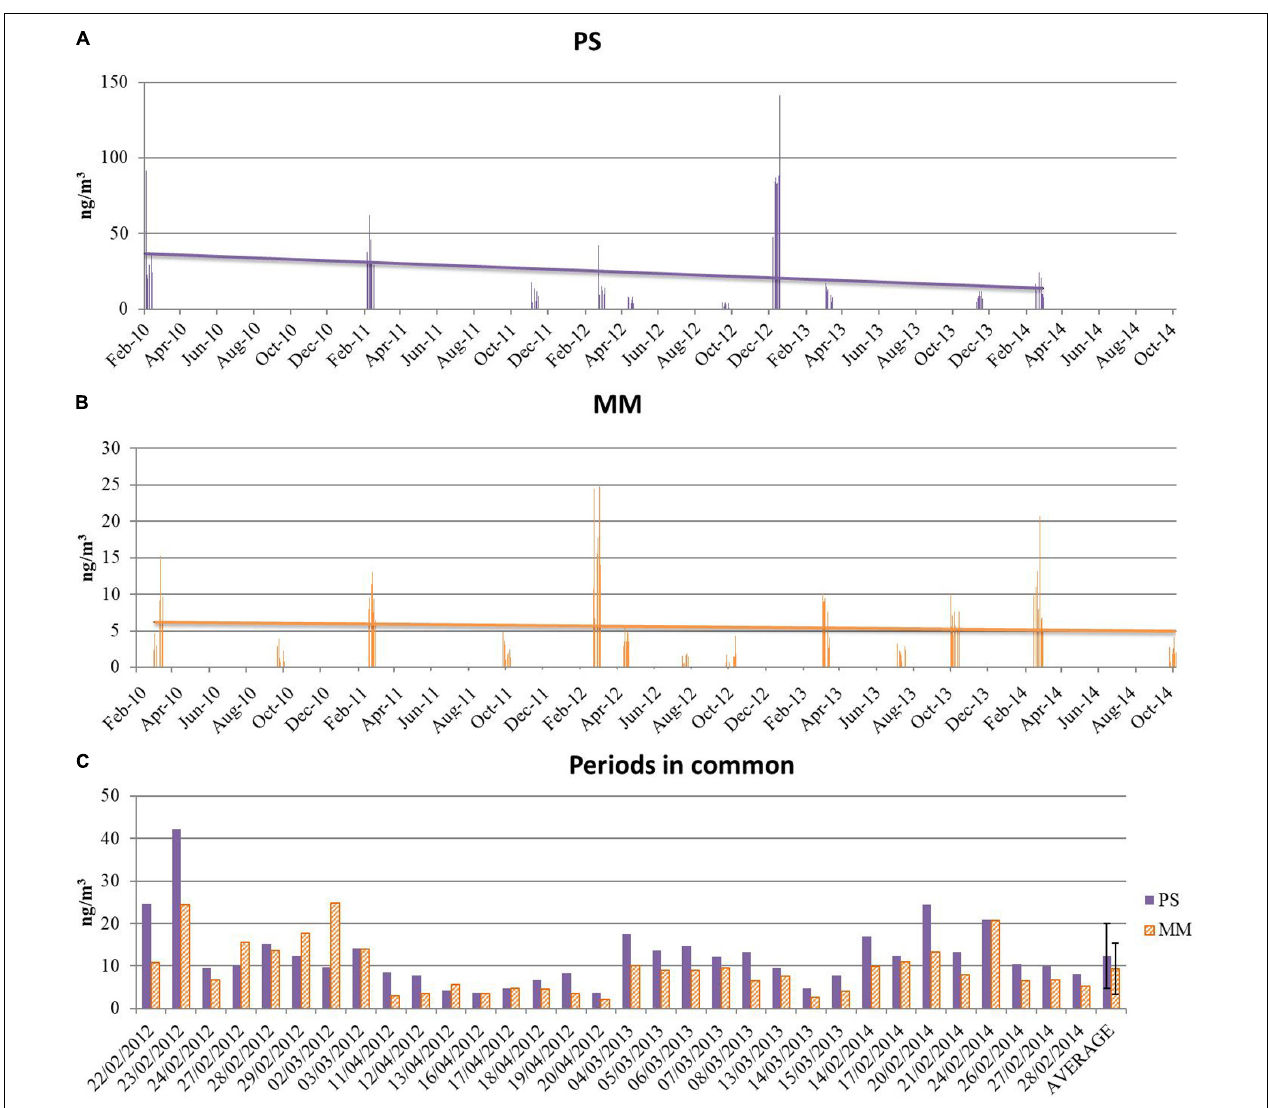
FIGURE 4 | Concentration of (cid:54) PAHs (G + P): (A) in Punta Sabbioni; (B) in Malamocco; and (C) in both sites in the simultaneously monitored periods, with standard deviation as error